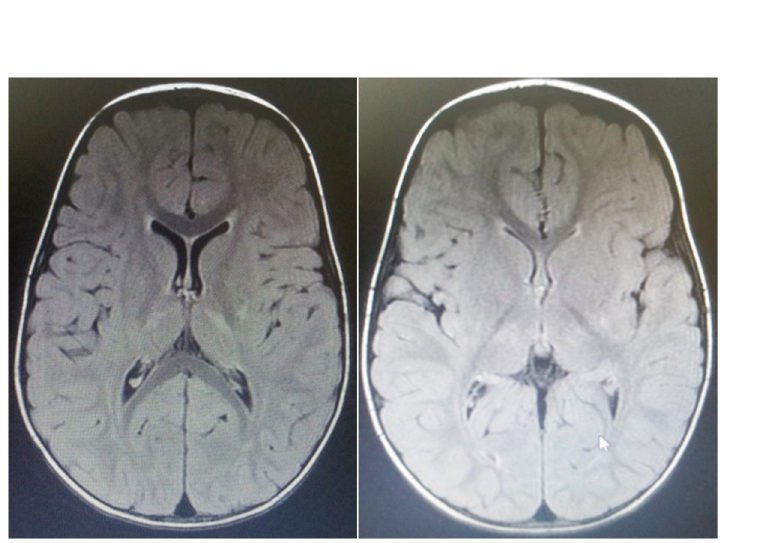
Fig 6. Case 19: MRI of a 3 year old male patient with unspecified form. MRI images of a 3 year old male child delivered at term who did not cry immediately after birth. Axial T2 FLAIR MR images showing bilateral basal ganglia and thalamic hyperintensities.